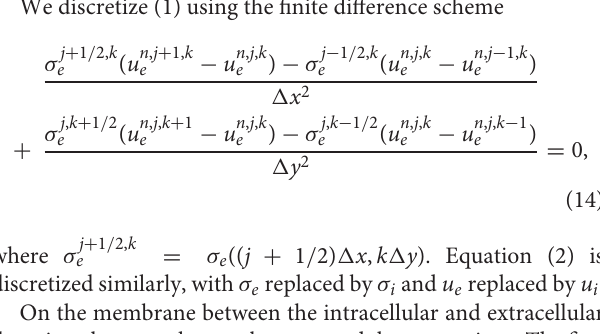
time t n = n 1 t and use an analogous notation for the